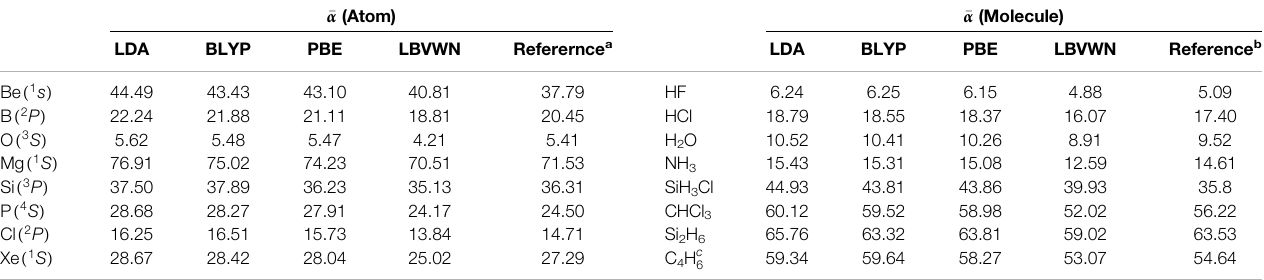
TABLE 3 | Average static polarizability, (cid:2) α for some atoms and molecules using FF KS method, for four XC functionals. All results in a.u. For details, see Mandal et al. (2019). (cid:2) α (Atom) (cid:2) α (Molecule) LDA BLYP PBE